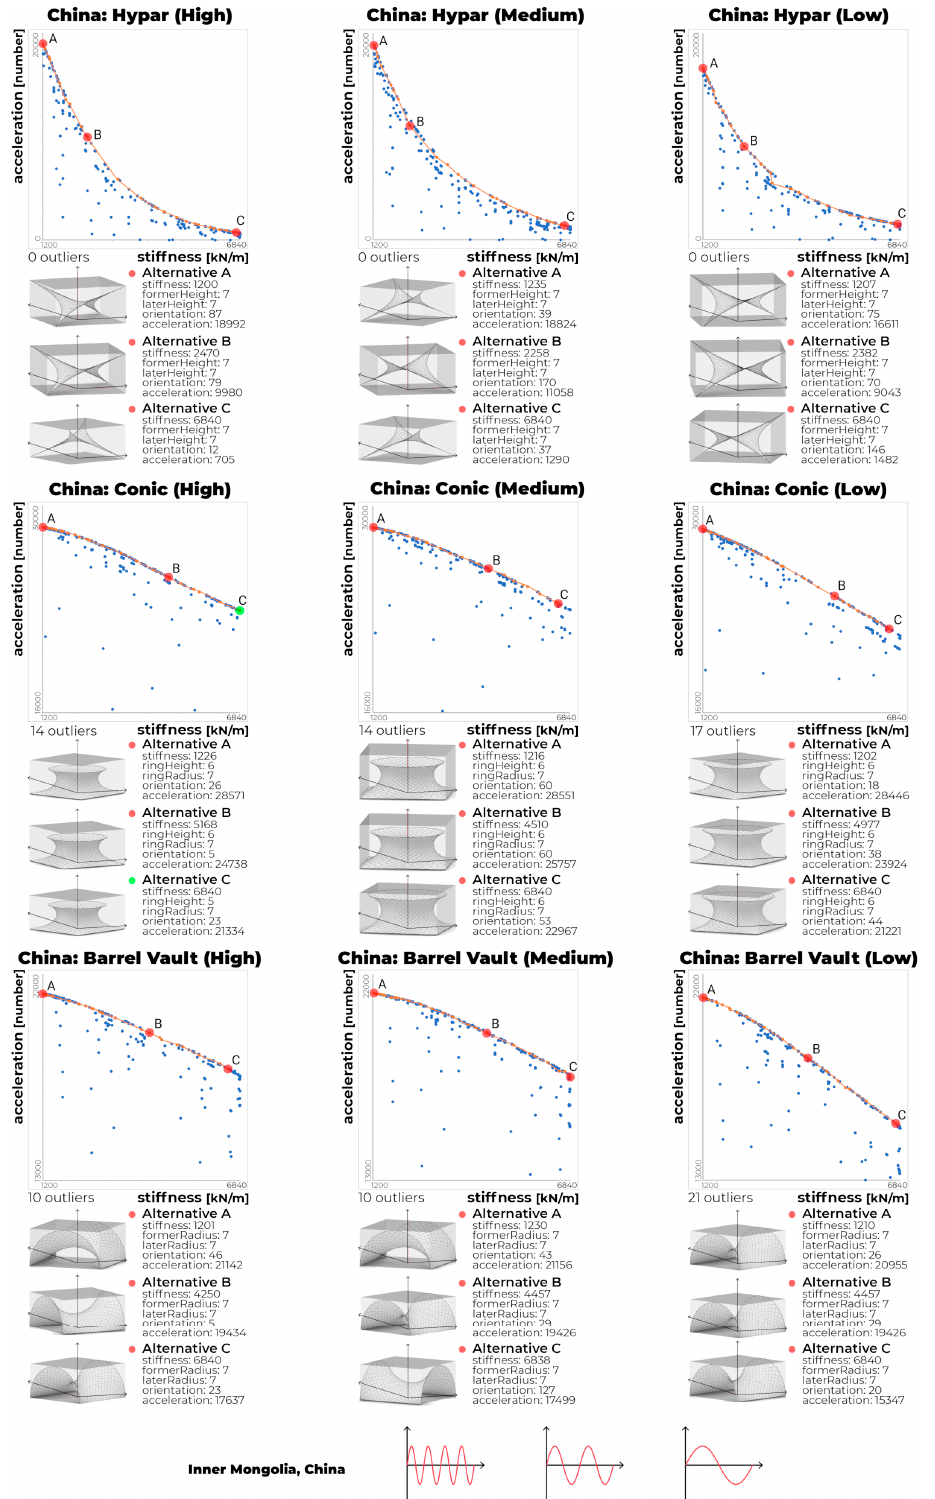
Figure 4. Pareto-optimization results for Inner Mongolia, China.